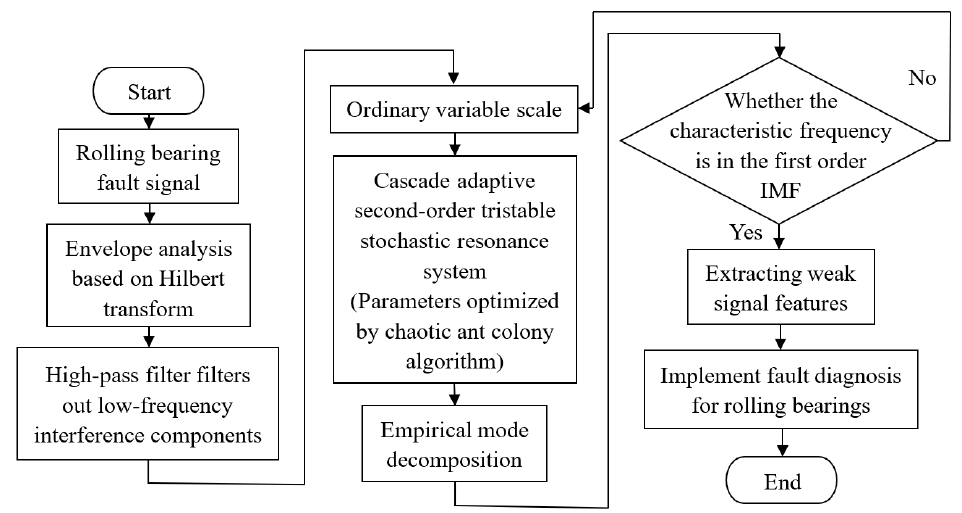
Figure 4. Fault diagnosis flow based on CASTSR and EMD.